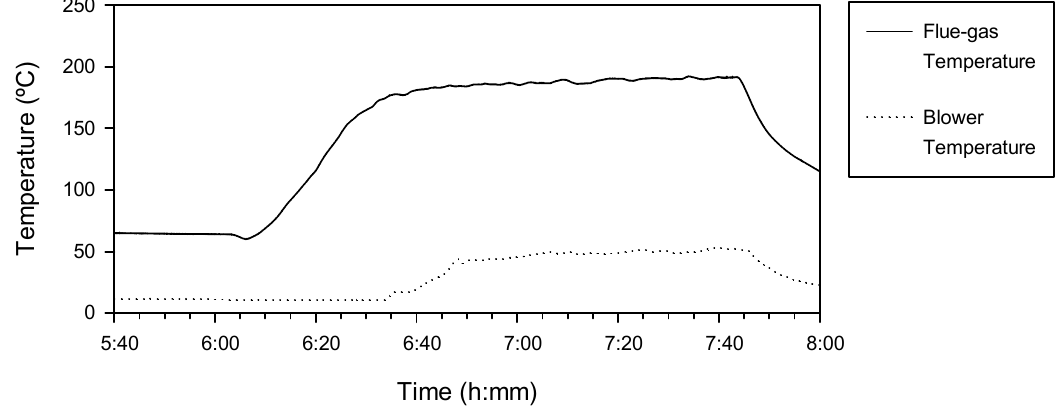
Figure A5. Flue-gas temperature over the period corresponding to Figure A4.